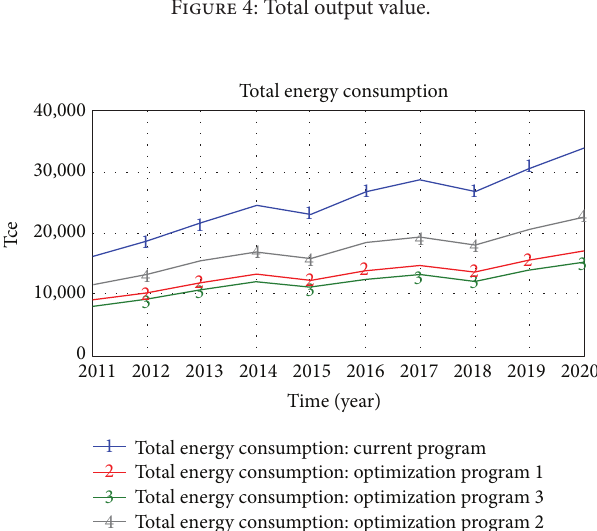
Figure 4: Total output